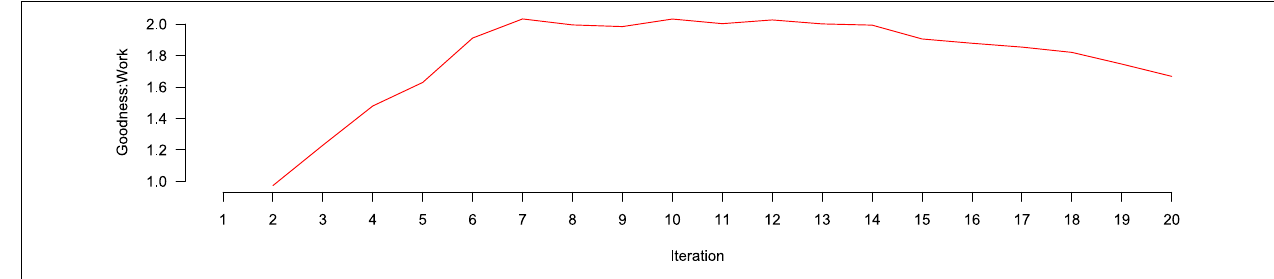
FIGURE 6 | Goodness: work ratio over iterations of active learning. No data exists at the first iteration because no active learning has yet taken place. Between iterations 2 and 7, the goodness:work ratio increases, being approximately level until iteration 15, where it begins to